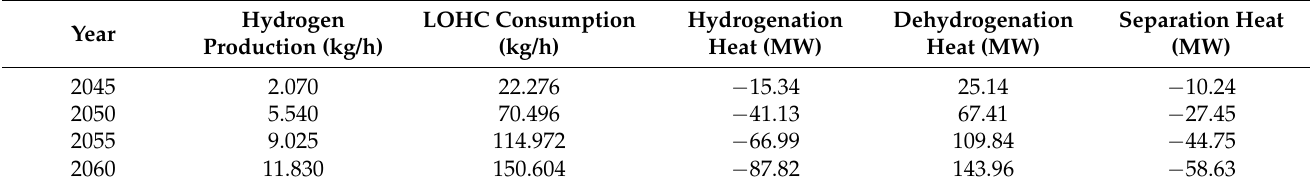
Table 10. Energy and mass balances results for LOHC (decalin-naphthalene system) hydrogen processes.